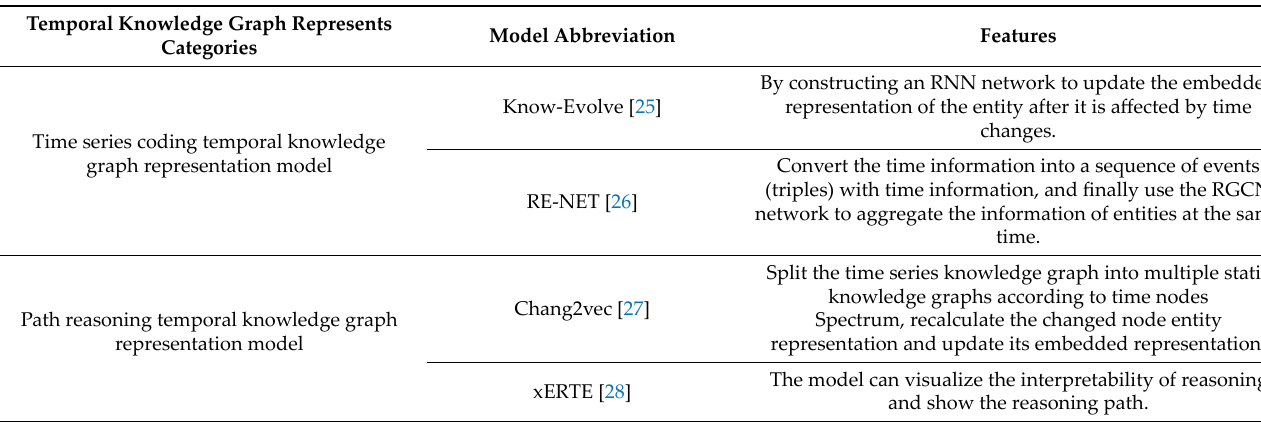
Figure 3. Knowledge Graphs of requirements based on IIoT network security. In TKG, each fact has a relation (or predicate) 𝑝 ∈ ℛ with subject entity 𝑠 ∈ ℰ and object entity 𝑜 ∈ ℰ within time 𝑡 ∈ 𝒯 . where ℰ and ℛ represent the vocabulary sets corresponding to entity and relation predicates, respectively, and T is the set of time periods or timestamps (if they exist). Bold words s, p, o, t represents the embedding vectors of subject entity s, predicate p, object entity o, and time t in the factual events with temporal information. Let 𝒢 (cid:3047) denote the snapshot of TKG in t time period, 𝑡 = (cid:4666)𝑡 (cid:3029) , 𝑡 (cid:3032) (cid:4667) , where 𝑡 (cid:3029) denotes the time when a relationship starts, and 𝑡 (cid:3032) denotes the time when a relationship ends. 𝑔 = (cid:4666)𝑠, 𝑝, 𝑜, 𝑡(cid:4667) represents the quadruple fact in 𝒢 (cid:3047) . Both TransE and TransH assume embedding entities and relations in the same space ℝ (cid:3038) . In TransR, for each triple (s, p, o), the entity embedding is set to s, o ∈ ℝ (cid:3038) , and the relation embedding is set to r ∈ ℝ (cid:3031) . Here, the dimensions owned in entity embedding and relationship embedding may not be the same, that is, k ≠ d. However, none of these three classical models contain temporal information. To solve this problem, we propose a new method